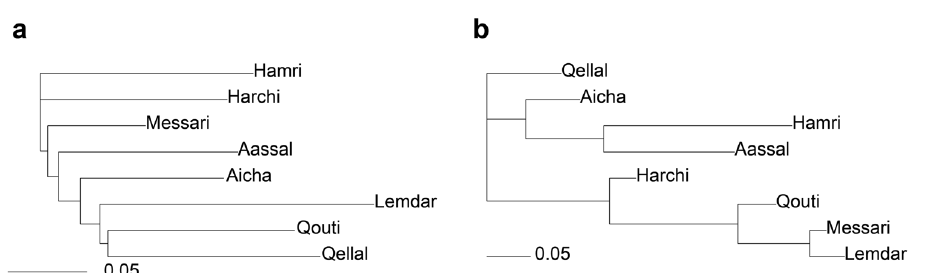
Figure 3. Genetic ( a ) and chemical ( b ) dendrograms. Independent matrices coding genetic distances between varieties were calculated from allele frequency data by neighbor-joining based on Nei distance. Chemical dendrogram was created by using neighbor joining based on the Bray–Curtis distance matrix for the averaged relative proportions of VOCs per